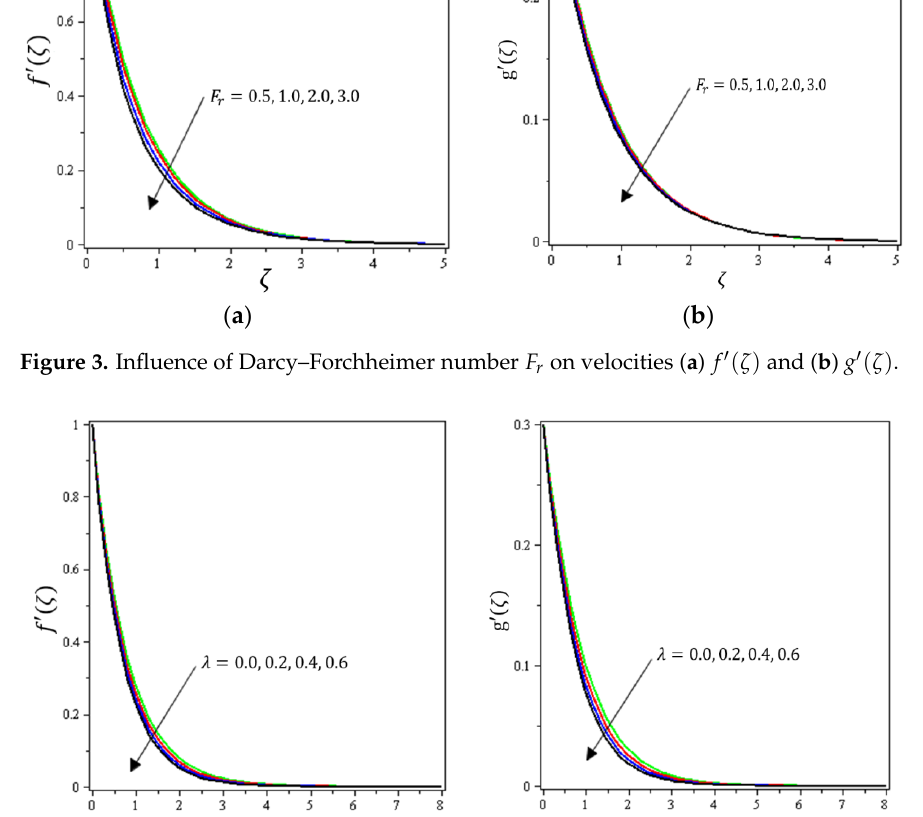
( a ) ( b ) Figure 5. Influence of material parameter 𝛼 on velocities ( a ) 𝑓′(𝜁) and ( b ) g ′(𝜁) .